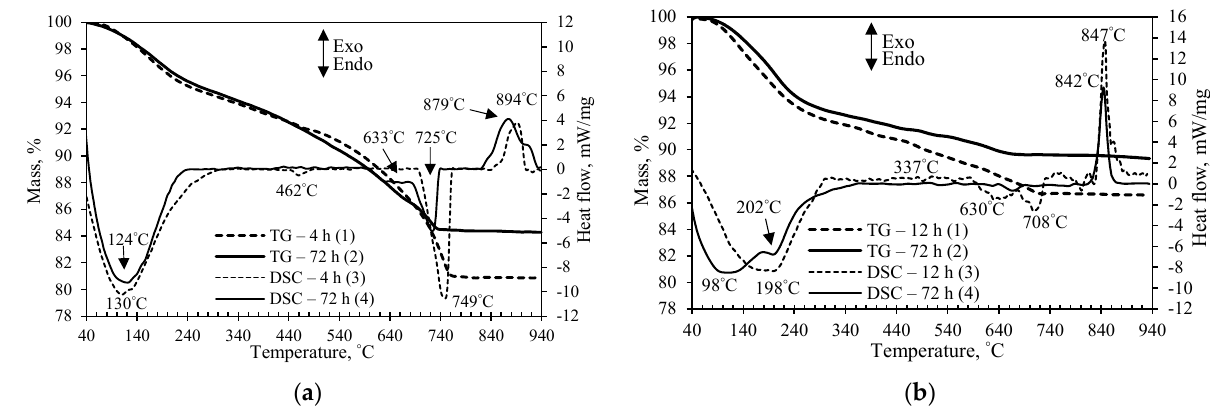
Figure 4. TG (1, 2) and DSC (3, 4) curves of the synthesis products from lime–GSW ( a ) and lime–calcined opoka ( b ) mixtures with CaO/SiO 2 = 1.0 at 200 °C after 12 h (1, 3) and 72 h (2, 4).